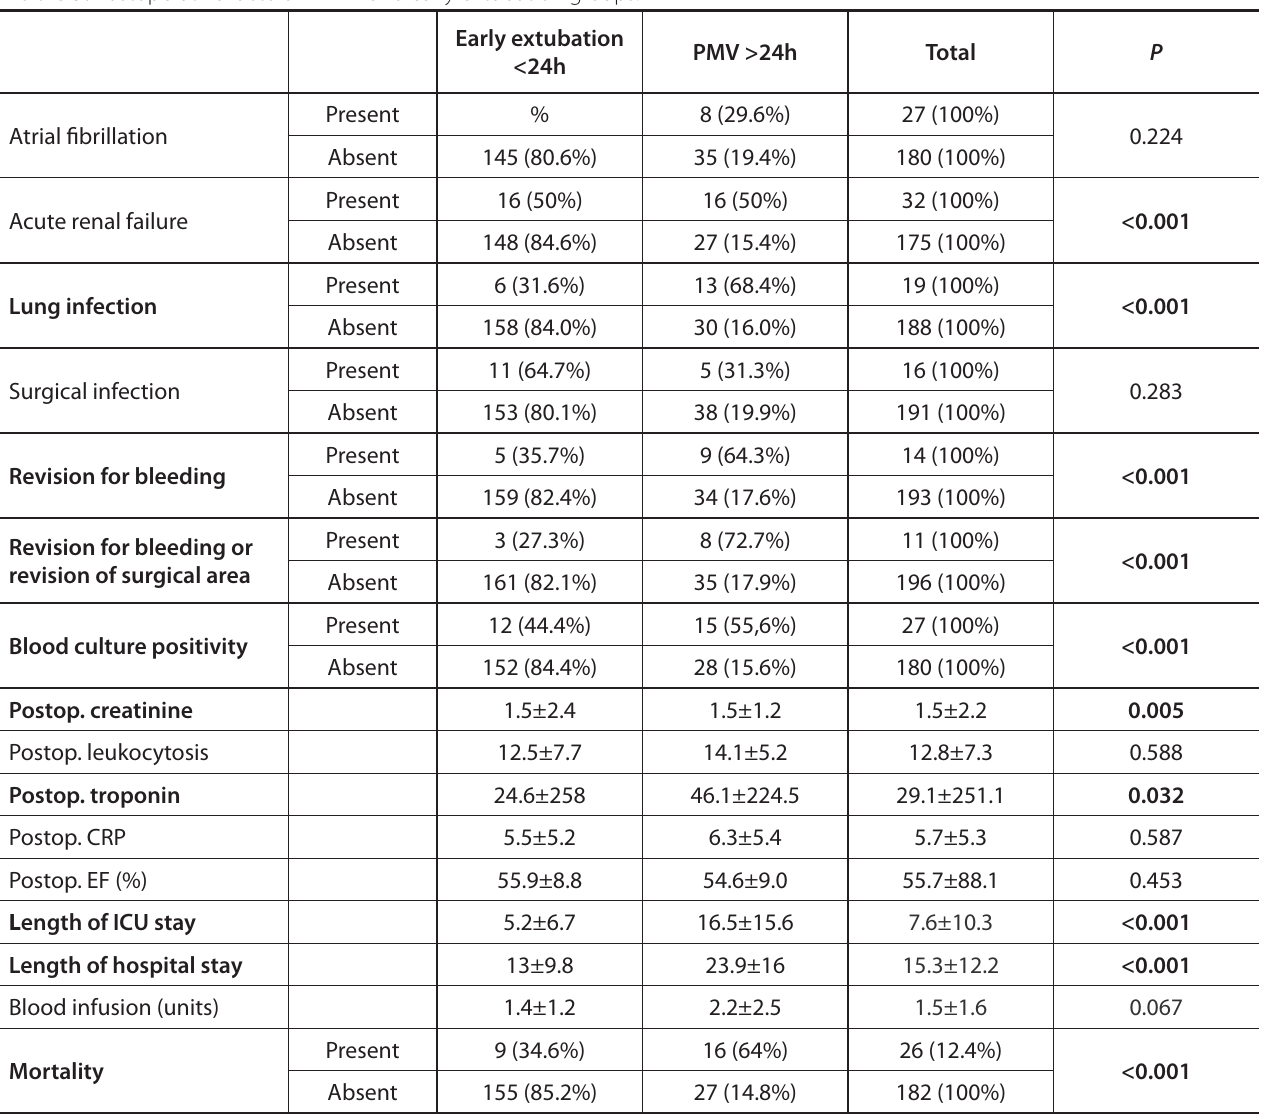
Table 3. Postoperative factors in PMV and early extubation